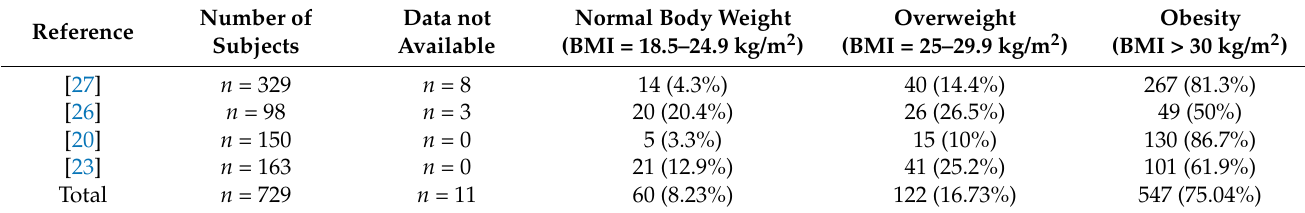
Table 2. Body weight in people with